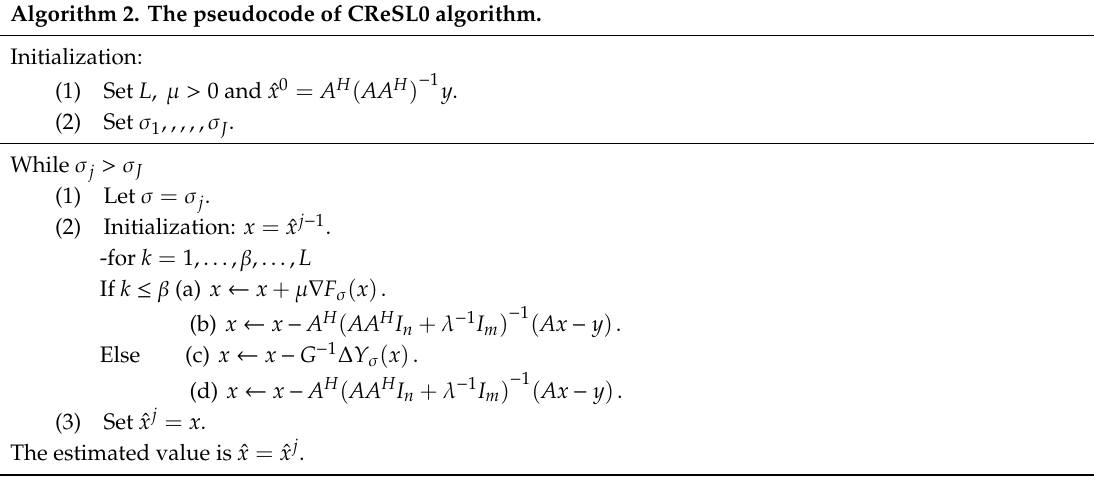
Algorithm 2. The pseudocode of CReSL0